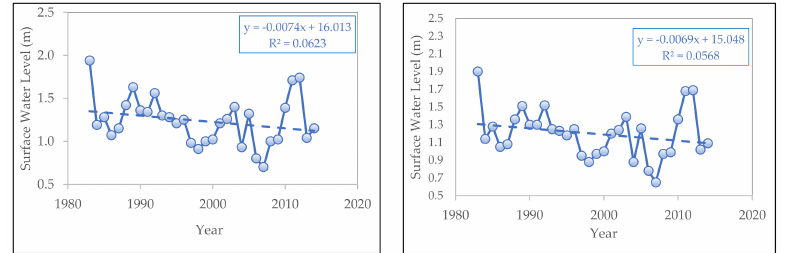
Figure 7. Trends in annual minimum high tide ( left ) and low tide ( right ) levels of the Dhaleswari River at